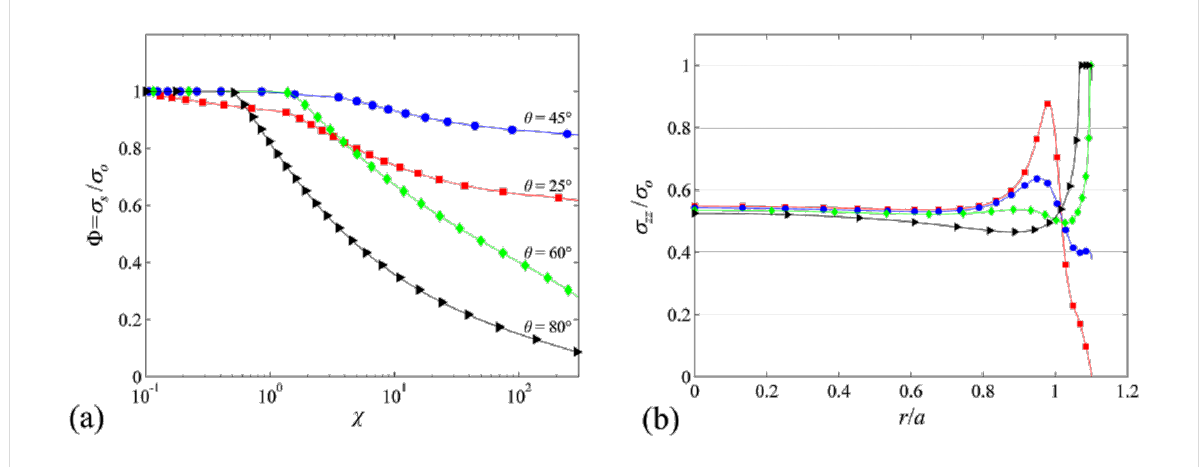
Figure 5: (a) Normalized pull-off stress as a function of χ for β = 1.1 and θ = {25°, 45°, 60°, 80°}. (b) Normalized stress at the tip for Δ / h = 0.0217 for the same β and θ as in (a). A cohesive zone is present at the edge both for θ = 60° and θ = 80°, while it has not formed for θ = 25° and θ = 45° yet.